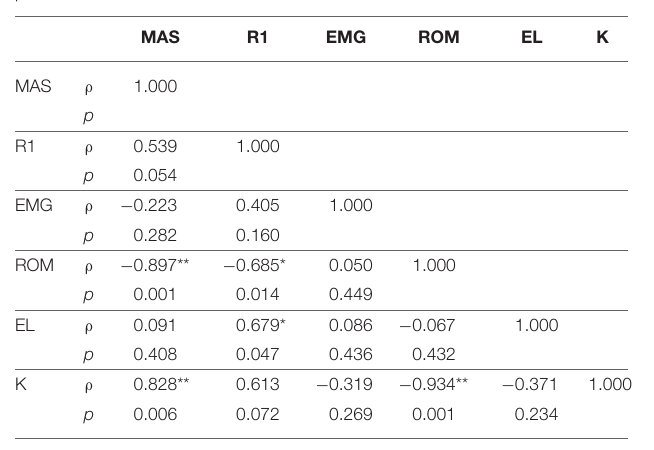
TABLE 2 | Spearman correlation coefficient p (and p -value) between the parameters.